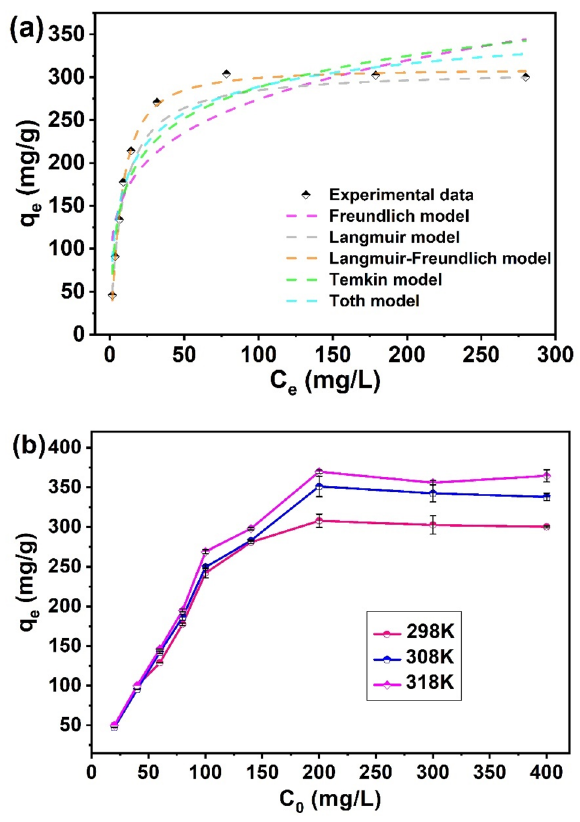
Figure 7. ( a ) Adsorption isotherm models of U(VI) on Fe 3 O 4 @SiO 2 @UiO 2 -66-TPP NPs (pH = 5.0 ± 0.1, T = 298 K and t = 60 min). ( b ) Effects of temperature on adsorption capacity of the adsorbent towards